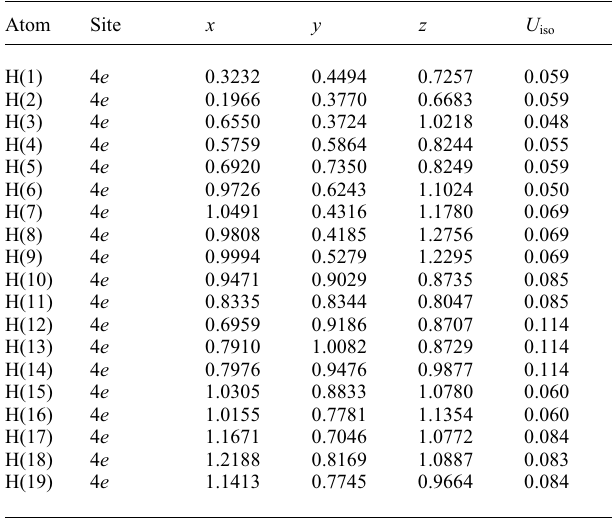
Table 2. Atomic coordinates and displacement parameters (in Å 2 )